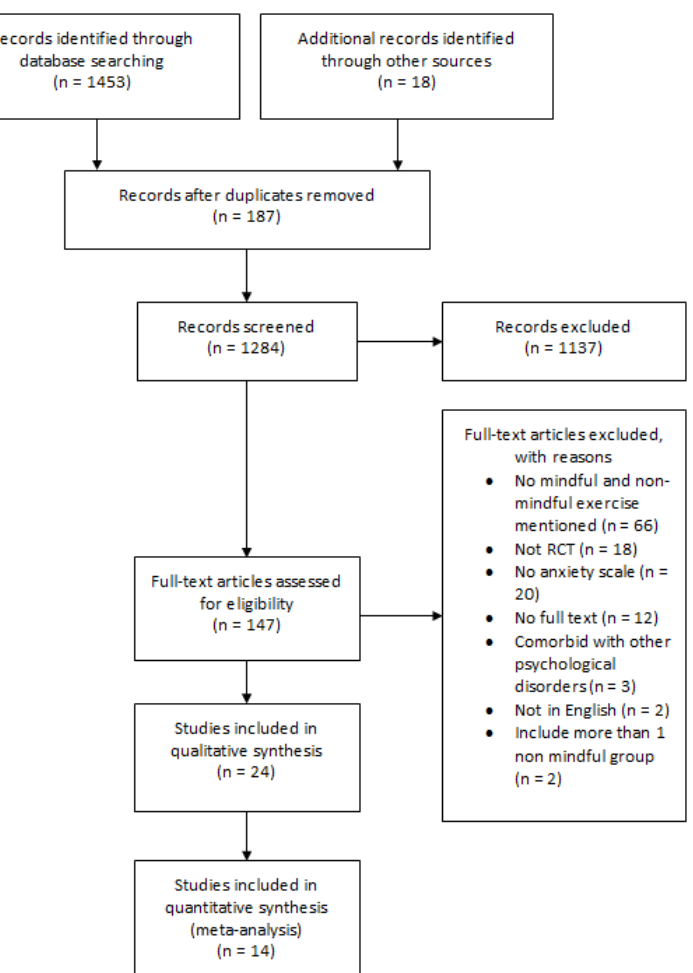
Figure 1. Flow diagram of the study selection.